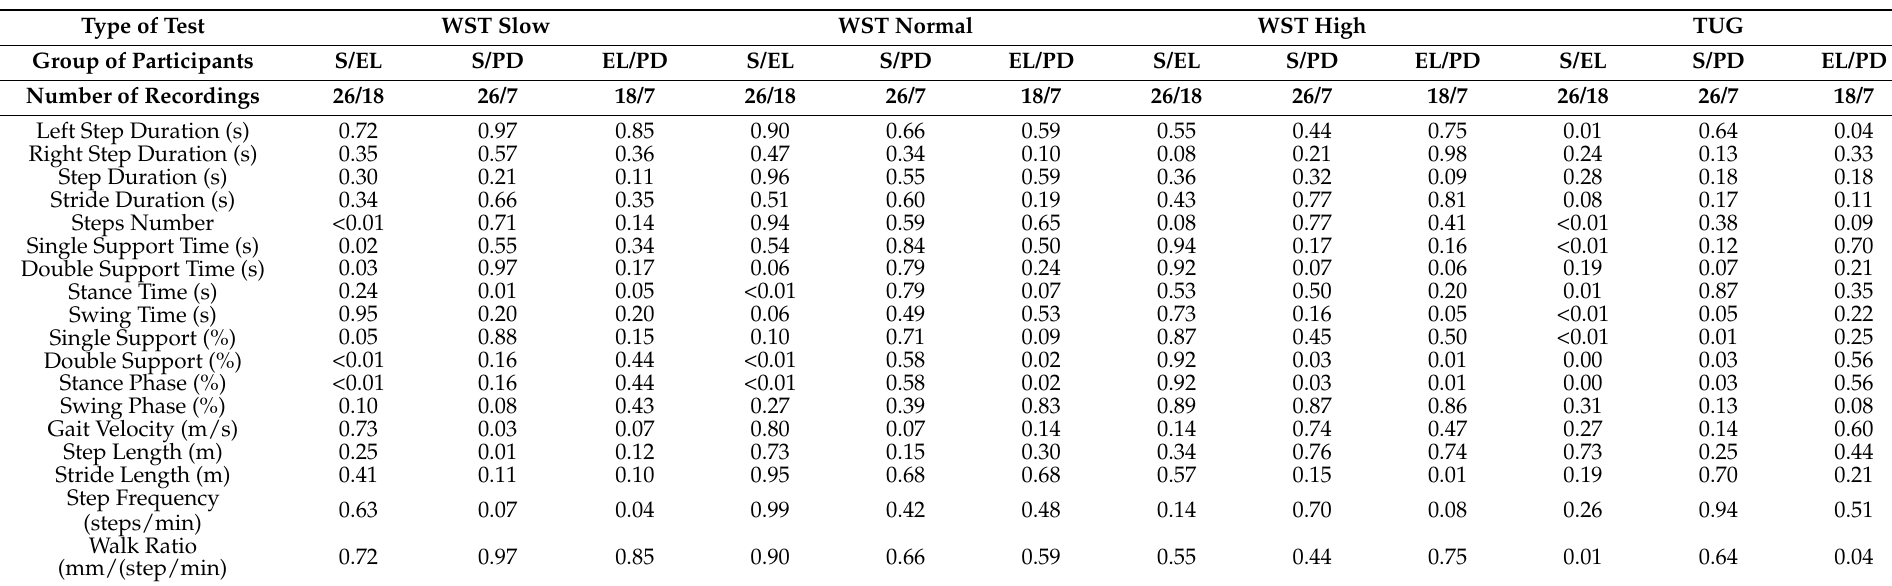
Table 9. p -values of the estimated results for Turns with statistically significant p < 0.01 for three combinations of participants’ groups (S/EL, S/PD, EL/PD) and for each different test. Type of Test TUG Group of Participants Number of